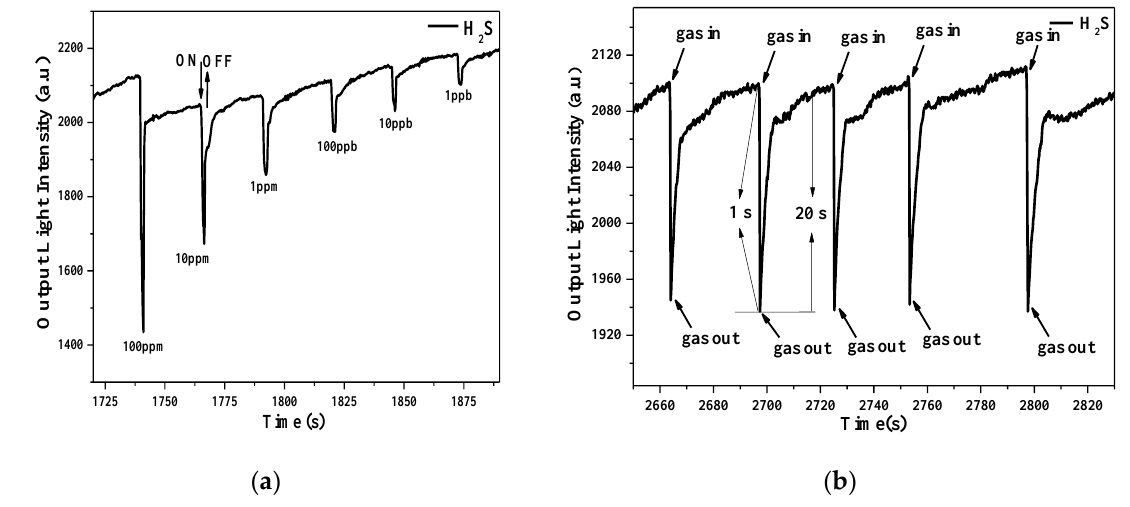
Figure 7. Nf-TNPP-film-based / K + -rxchanges optical-waveguide (OWG)-sensor performance. ( a ) Response reproducibility and ( b ) response-recovery curve over five cycles for 100 ppb H 2 S gas.